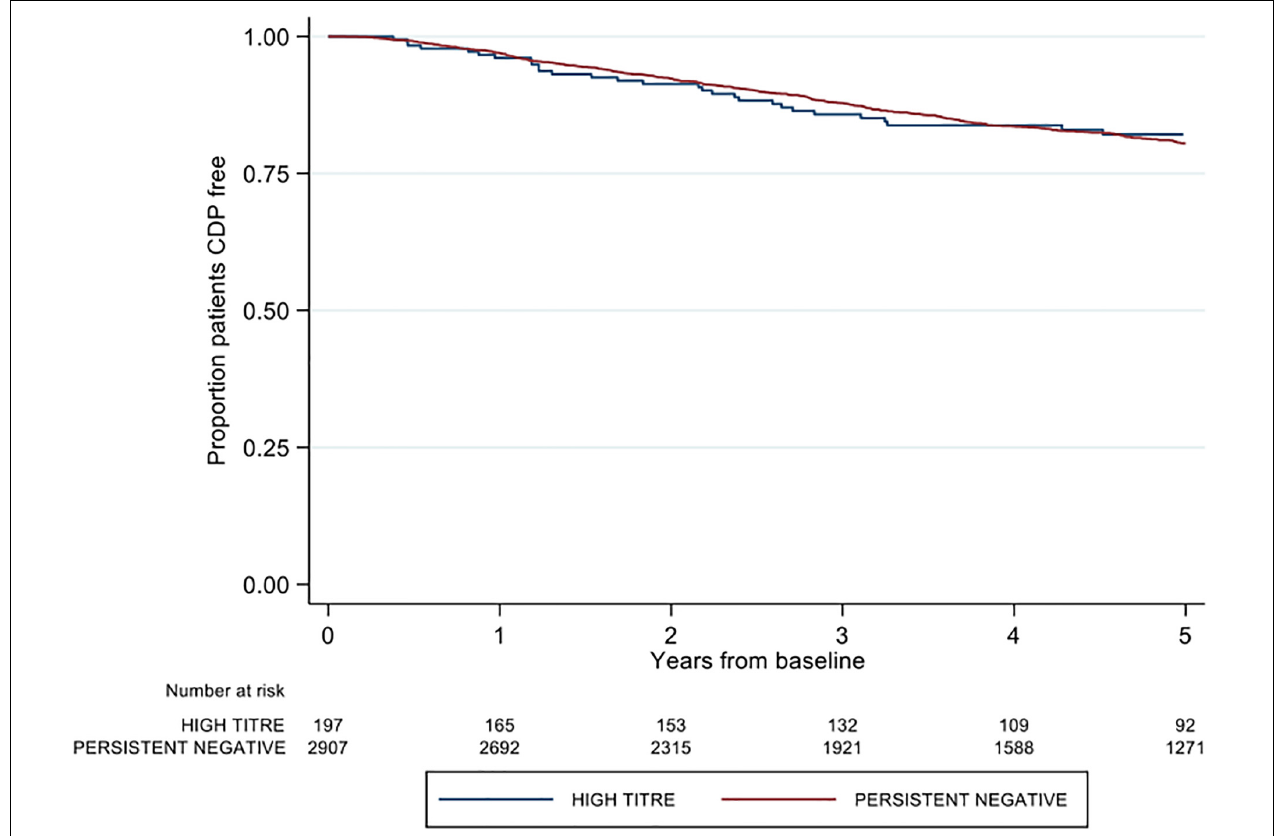
FIGURE 3 | Kaplan-Meier curve demonstrating the rate of time to first post-baseline three month confirmed disability progression by neutralizing antibody titre group over a five-year period. CDP = confirmed disability